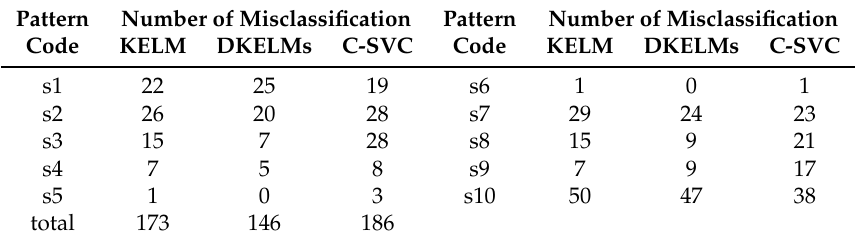
Table 9. Misclassification of each single component failure pattern through different